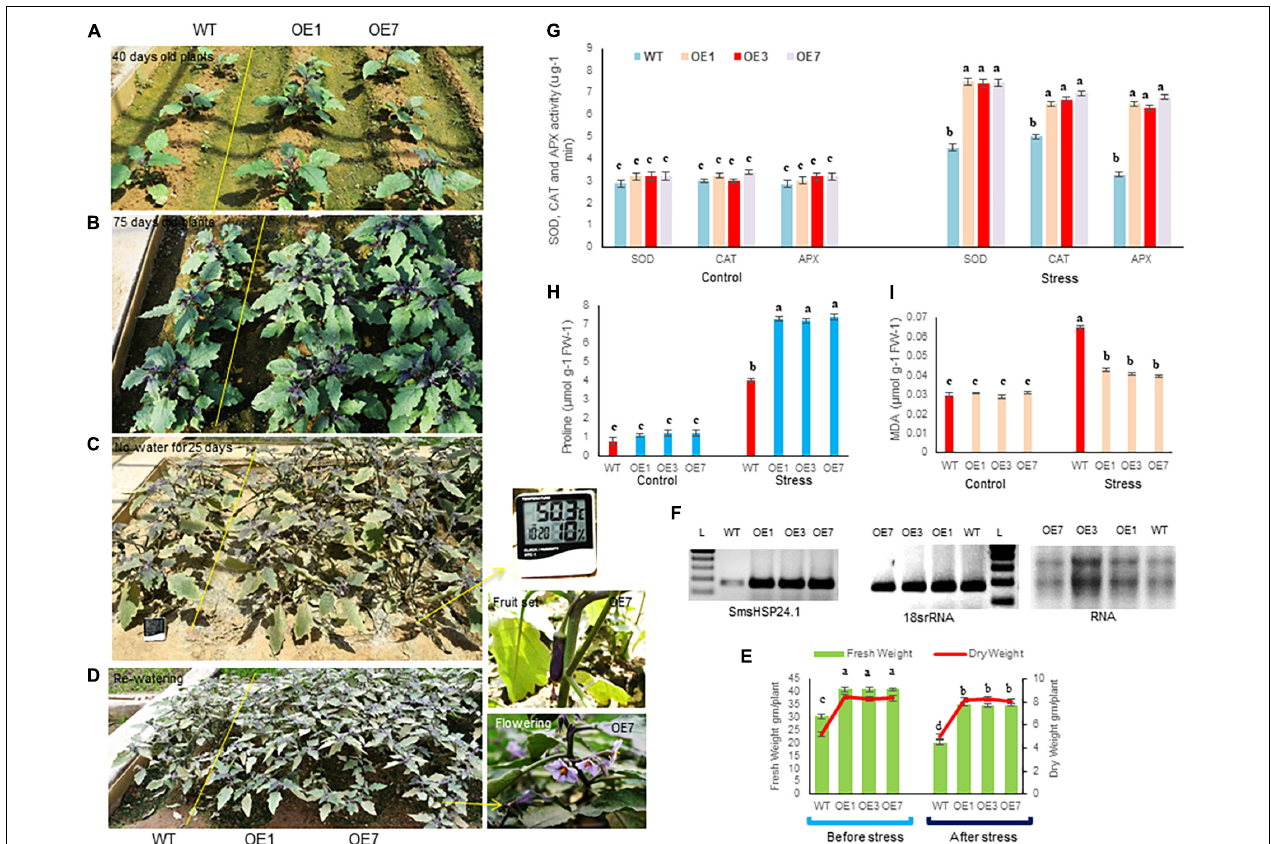
FIGURE 4 | Transgenic plants overexpressing SmsHSP24.1 maintained physiological balance at the field level under combined (heat and drought) stress. (A,B) Mature transgenic as well as WT plants grown in normal field conditions. (C) Phenotypes of 75 days old eggplant seedlings imposed by water withdrawal for 25 days with 45 ◦ C average heat from nature. (D) Phenotypes of transgenic and WT seedlings after re-watering for 15 days. Initiation of flower and fruit sets after recovery from stresses. (E) Total fresh weight and dry weight were significantly higher in all transgenic seedlings under control and stress conditions. Data are M ± SD ( n = 3). The letters a, b, c, and others indicate significant differences between different lines ( P < 0.05). (F) Semi-quantitative RT-PCR analysis of SmsHSP24.1 from field-grown OE and WT lines show increased accumulation of SmsHSP24.1 transcript in all OE lines both under control and stress conditions. (G–I) Different biochemical parameters such as proline, MDA, and ROS-scavenging enzymes such as superoxide dismutase (SOD), ascorbate peroxidase (APX), and catalase (CAT) were determined in transgenic as well as WT lines. Data are M ± SD ( n = 3). The letters a, b, c, and others indicate significant differences between samples from different OE lines ( P <